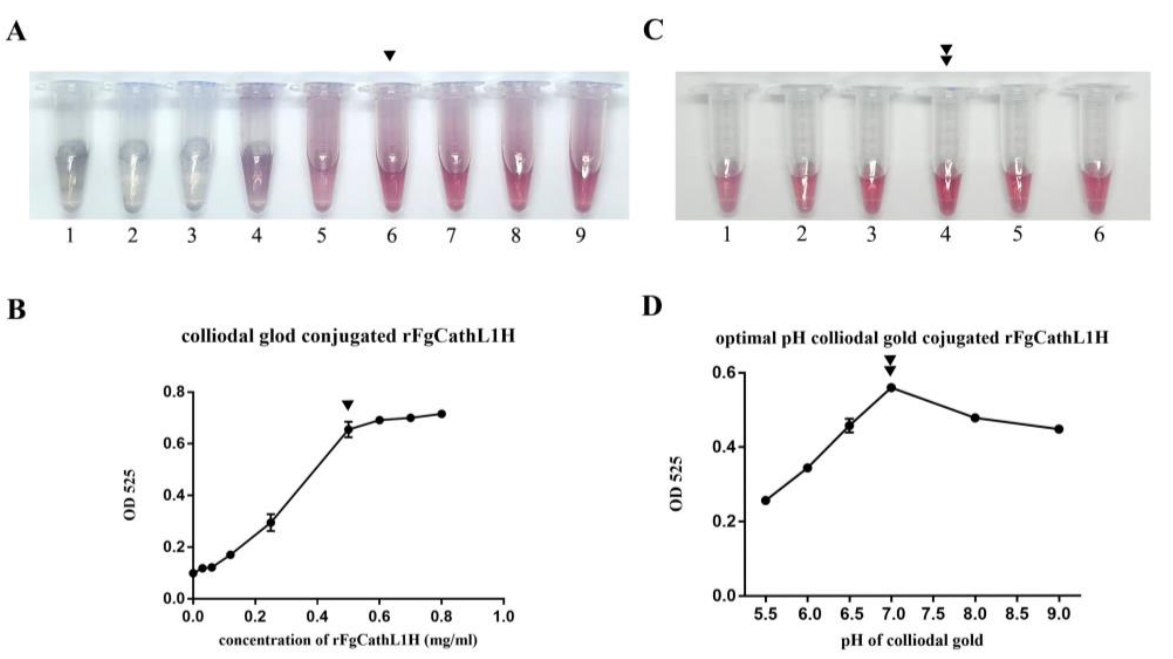
Figure 3. Determination of optimum concentration and pH value of rFgCathL1H conjugated colloidal gold. Photograph of the different concentrations of rFgCathL1H. The color of the rFgCathL1H-conjugated gold solution changed color from red to clear when the concentration was not appropriate. In Figure ( A ), the optimal concentration of rFgCathL1H marked with colloidal gold (1) 0 mg/mL, (2) 0.03125 mg/mL, (3) 0.0625 mg/mL, (4) 0.125 mg/mL, (5) 0.25 mg/mL, (6) 0.5 mg/mL, (7) 0.6 mg/mL, (8) 0.7 mg/mL, and (9) 0.8 mg/mL, from left to right. In Figure ( B ), determining the op-